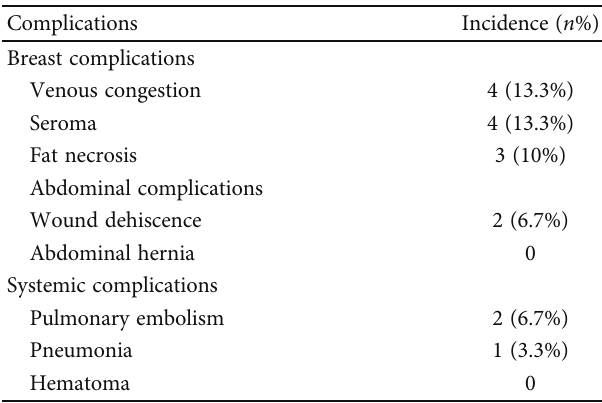
Figure 1: Comparison of two groups: operating time. Table 4: Operative